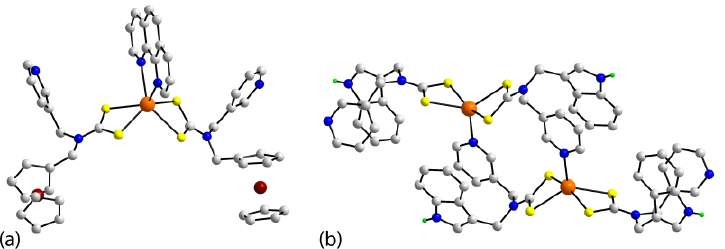
Figure 8. Molecular structures of ( a ) mononuclear Cd(L 13 ) 2 (1,10-phenanthroline) ( 27 ) and ( b ) di-